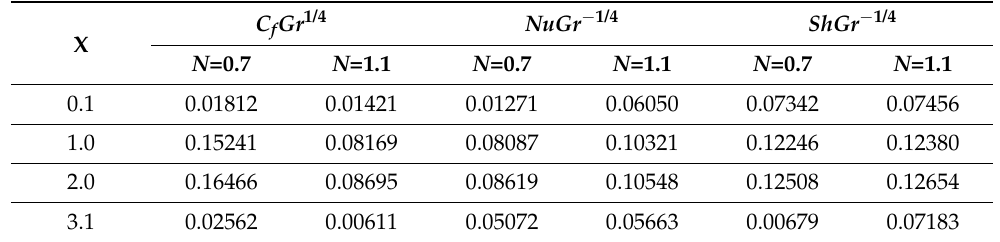
Table 3. Outcomes of the radiation parameter N on (a) the skin friction coefficient C f Gr 1/4 , (b) Nusselt NuGr − 1/4 , and (c) the Sherwood number ShGr − 1/4 when Nt = 0.2, Nb = 0.3, Sc = 10.0, and Pr =